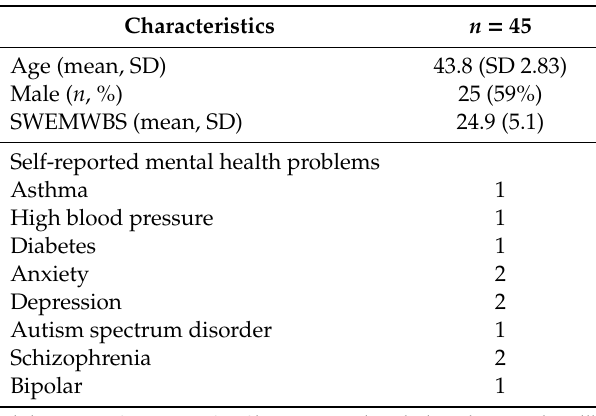
Table 1. Characteristics of